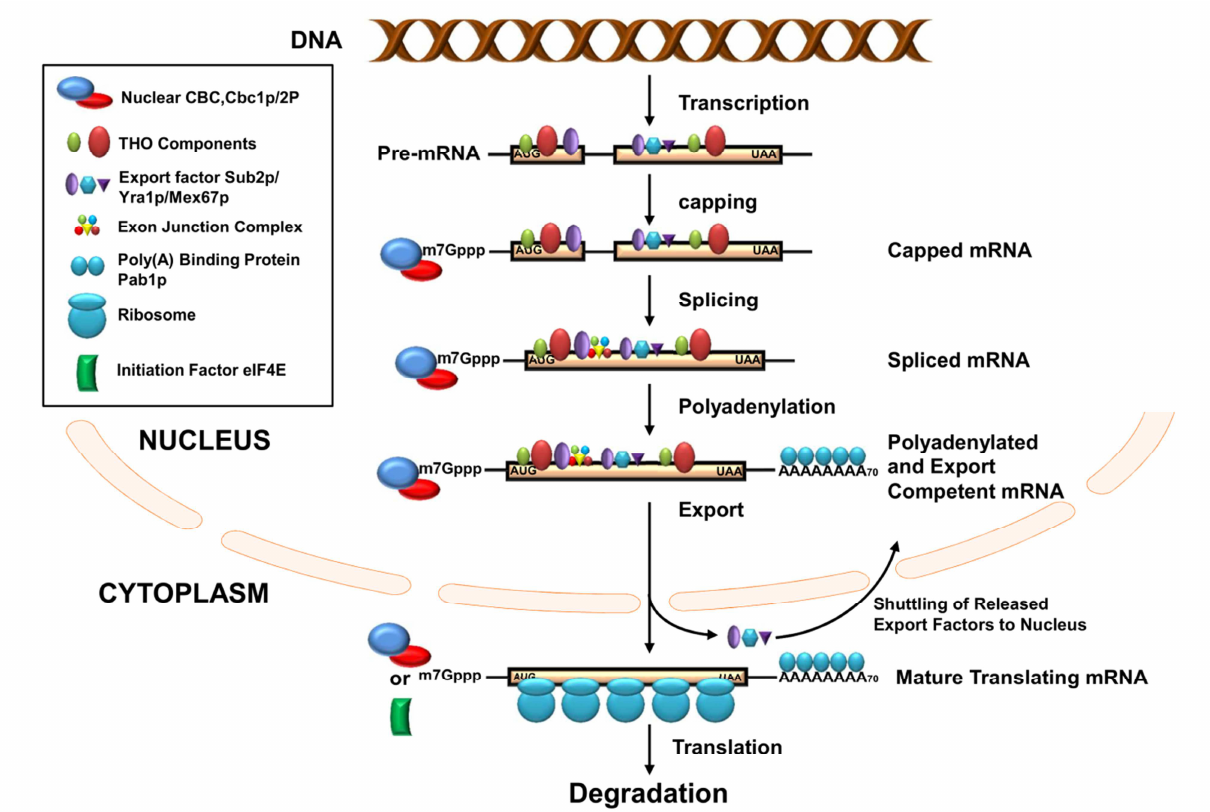
FIGURE 1: mRNA life-cycle in eukaryotic cells. Schematic view of the nuclear and cytoplasmic phases of the mRNA life cycle. Various mRNPs which are recruited onto/associated with the maturing transcripts during different stages are schematically indicated by solid colored sym- bols. Symbols are either annotated directly or denoted in the associated legend box. THO components/maturing factors/mRNA-binding proteins are released from mRNA once the mRNA matures and becomes export-competent. Similarly, export factors are also released from the transcript body once the mRNA arrives at the cytoplasm and shuttle back into the nucleus. In the cytoplasm, mRNAs may remain associ- ated either with nuclear CBC (while undergoing a pioneer round of translation) or with eIF4E (while undergoing subsequent steady state translation) which is indicated in the diagram. For simplicity, other mRNA binding proteins remaining associated with translating mRNAs are not shown except for CBC and eIF4E. AUG and UAA are indicating the beginning and end of the open reading frame (ORF) carried by the